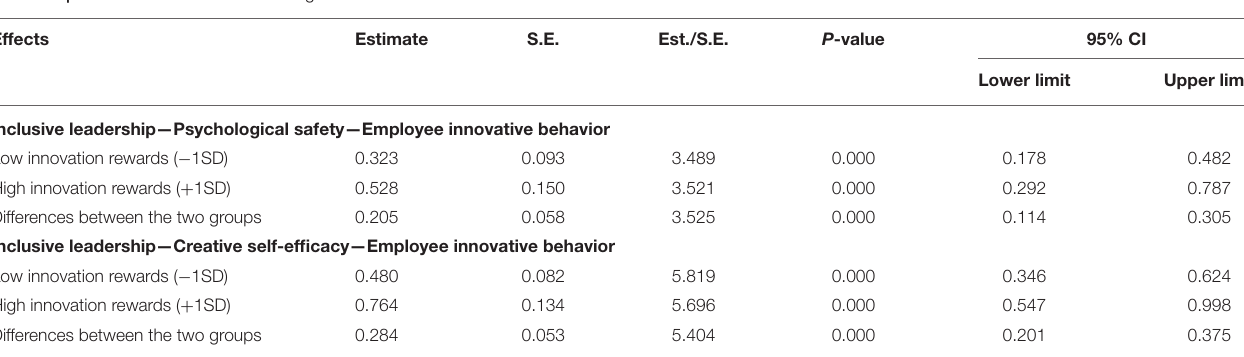
TABLE 5 | Results of moderated mediating effect